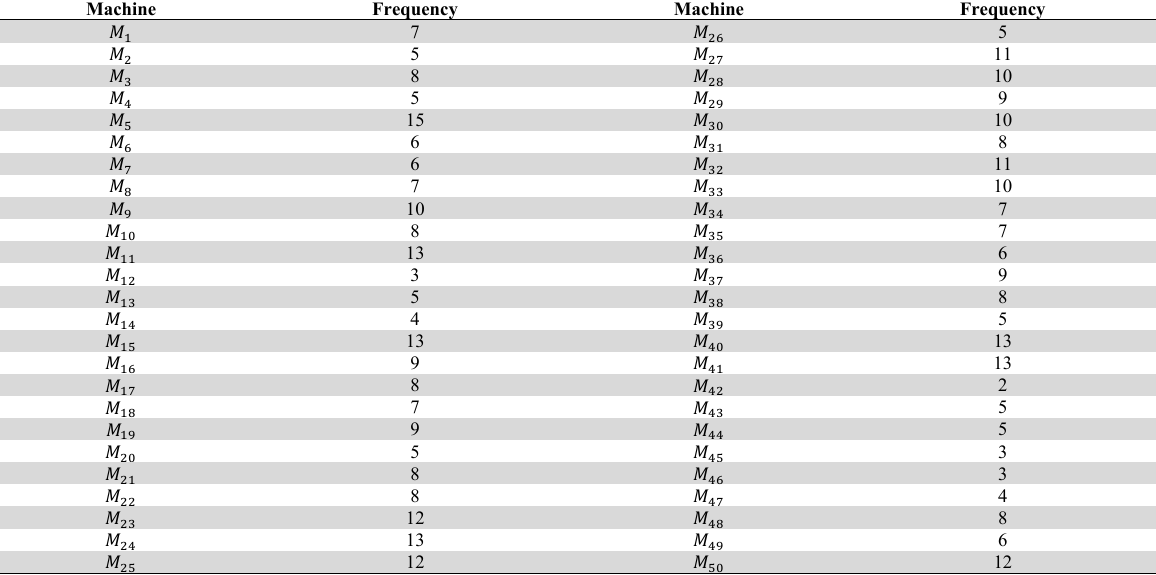
Machine Frequency in Training